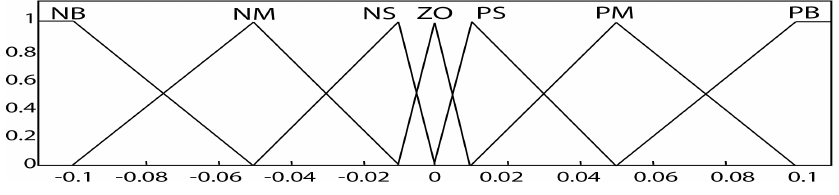
Figure 4. Membership functions of e ( t ) .